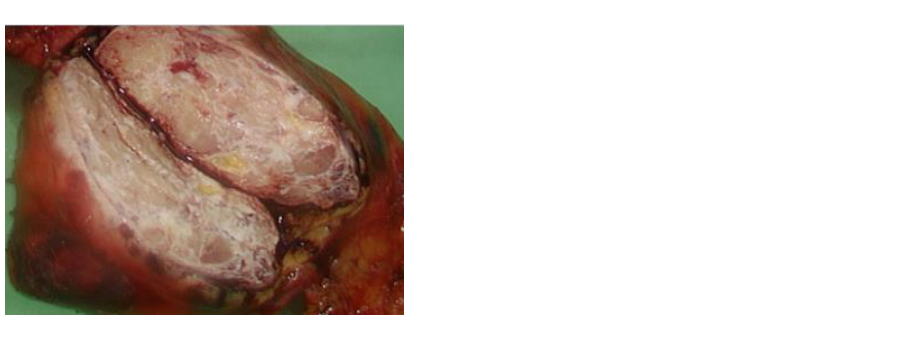
Figure 4. A 7.2 cm × 5.6 cm × 4 cm mass identified after operation of Video-Assisted Thoracoscopic Surgery.